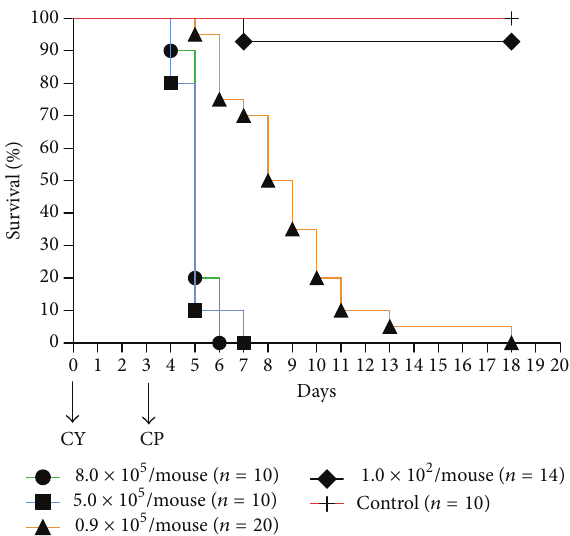
Figure 2: Survival curves. The mortality showed positive asso- ciations with infectious dose. And the optimal inoculum for C. parapsilosis was 0.9 × 10 5 CFU per immunosuppressed mouse.